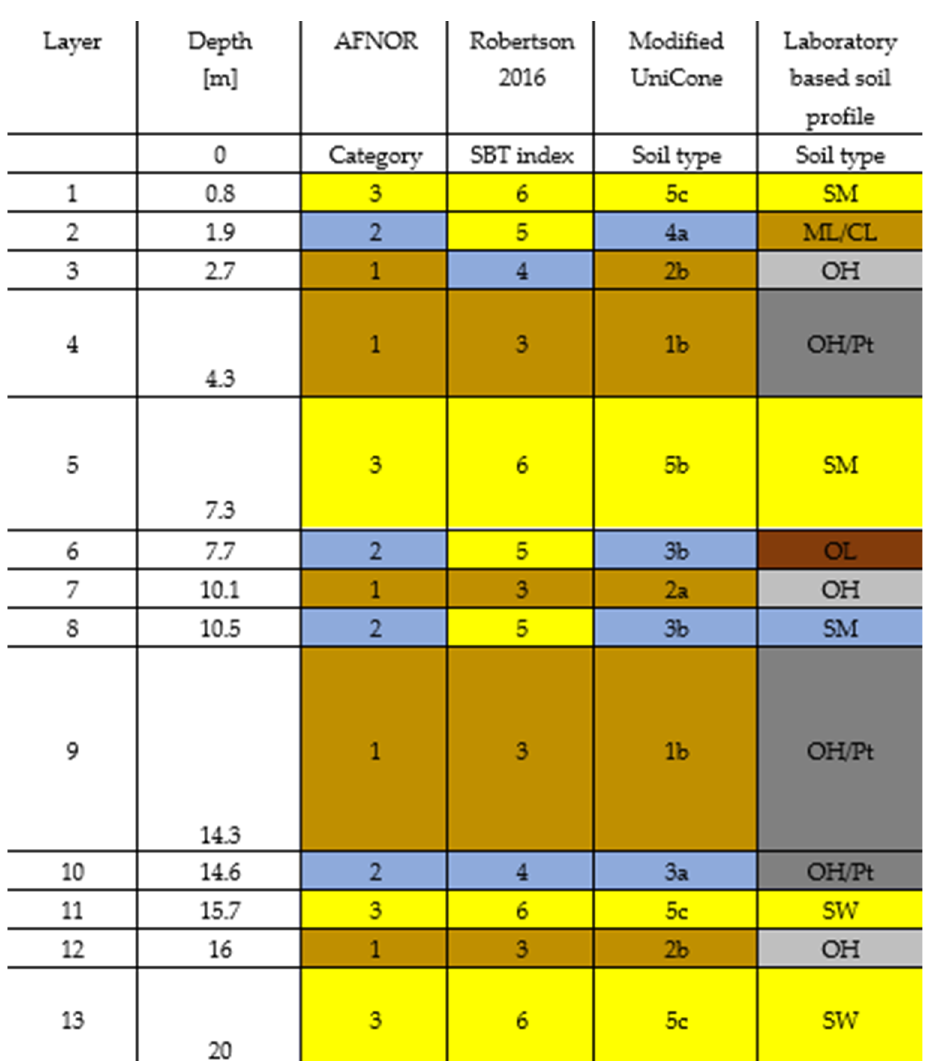
Figure 4. The Jazowa site soil profile according to the presented methodologies. Soil type description of Figure 4: AFNOR category: 1—clayey soil, 2—Intermediate soil, 3—sandy soil. Robertson 2016